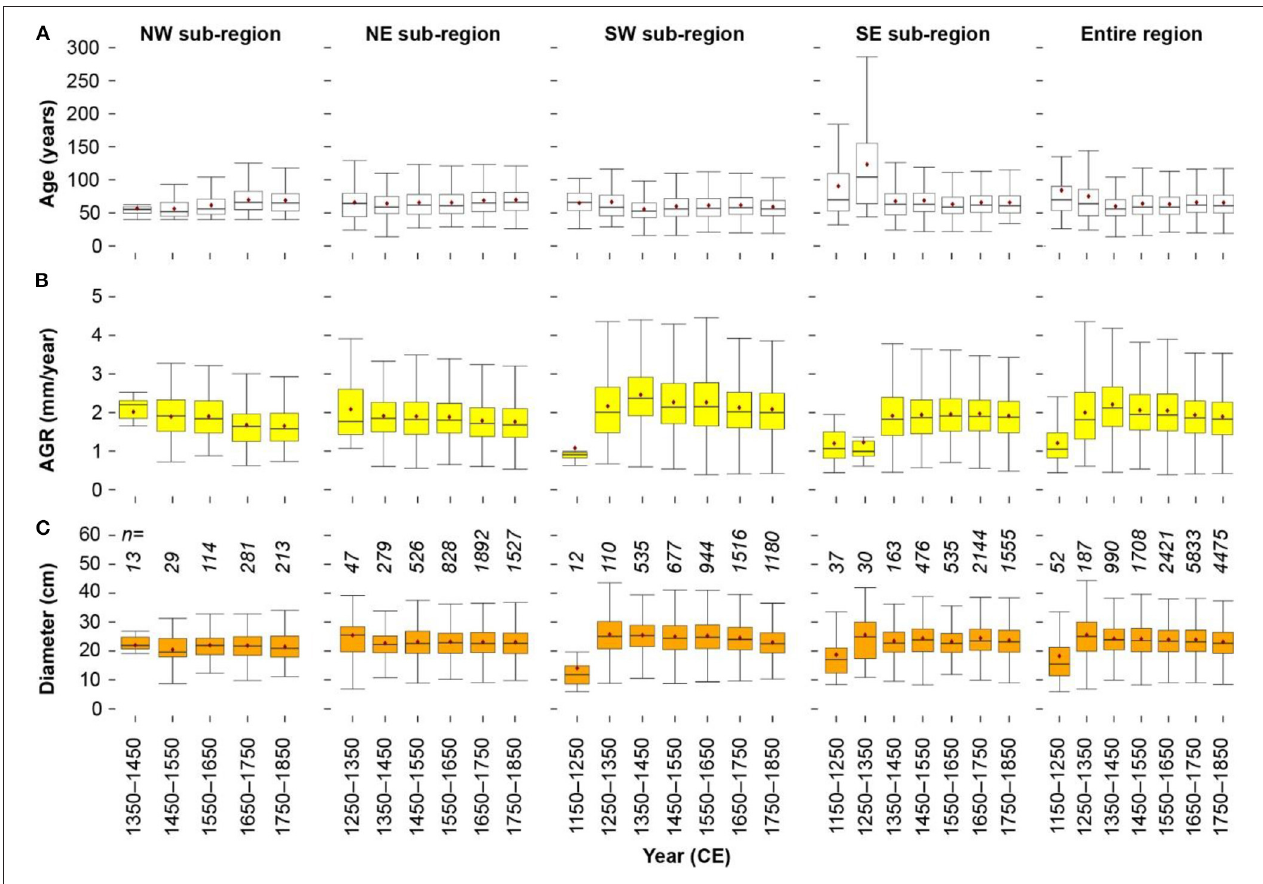
FIGURE 2 | Temporal distribution of (A) tree age, (B) average growth rates (AGR), and (C) tree diameter for the dendrochronologically dated spruce timber shown for 100-year periods and for the four sub-regions [northwest (NW), northeast (NE), southwest (SW) and southeast (SE)] and the entire study region. Numbers of spruce samples for each 100-year period is indicated by numbers (in italic) in (C)